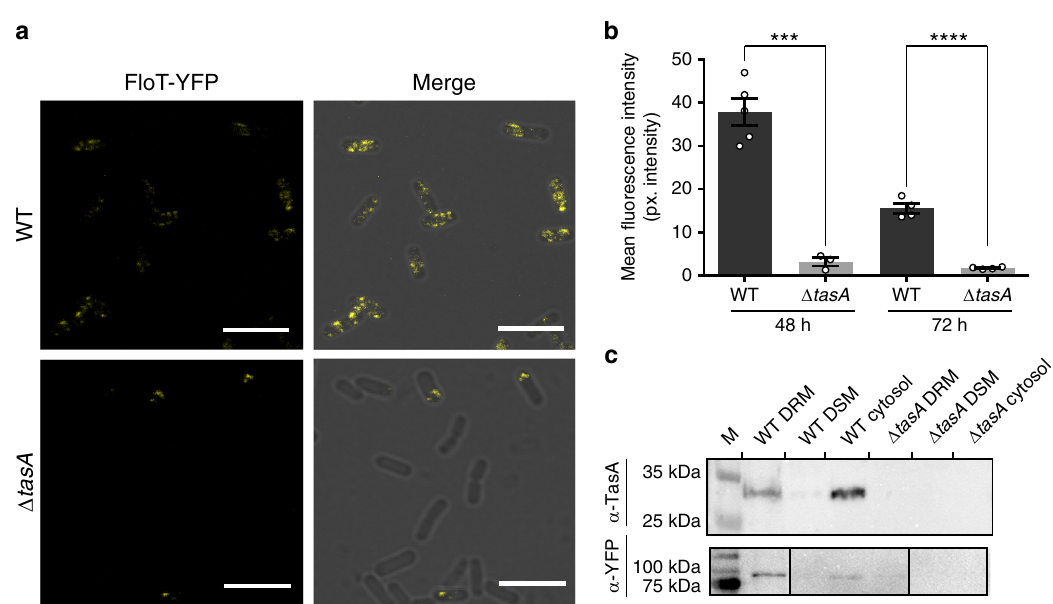
Fig. 7 TasA is located in the DRM fraction of the cell membrane. a Representative confocal microscopy images showing WT or Δ tasA cells expressing the fl oT-yfp construct at 72 hours. WT images show the typical punctate pattern associated to FloT. That pattern is lost in Δ tasA cells. b Quanti fi cation of fl uorescence signal in WT ( N = 5 at 48 h and N = 4 at 72 h) and Δ tasA ( N = 3 at 48 h and N = 4 at 72 h) samples. N indicates the number of colonies examined over three independent experiments. Average values are shown. Error bars represent the SEM. Statistical signi fi cance was assessed via two- tailed independent t -tests at each time-point (*** p value = 0.0002 **** p < 0.0001). For each experiment and sample, at least three fi elds-of-view were measured. c Western blot of different membrane fractions exposed to an anti-TasA or anti-YFP antibodies. Both antibodies have been used with the same set of samples in two independent immunoblots. Experiments have been repeated at least three times with similar results. Immunoblot images have been cropped (top image) or cropped and spliced (bottom image) for illustrative purposes. Black lines over the blot images delineate boundaries of immunoblot splicing. The three slices shown slices are derived from a single blot. Raw images of the blots presented in this fi gure can be found in the source data. Source data are provided as a Source Data fi